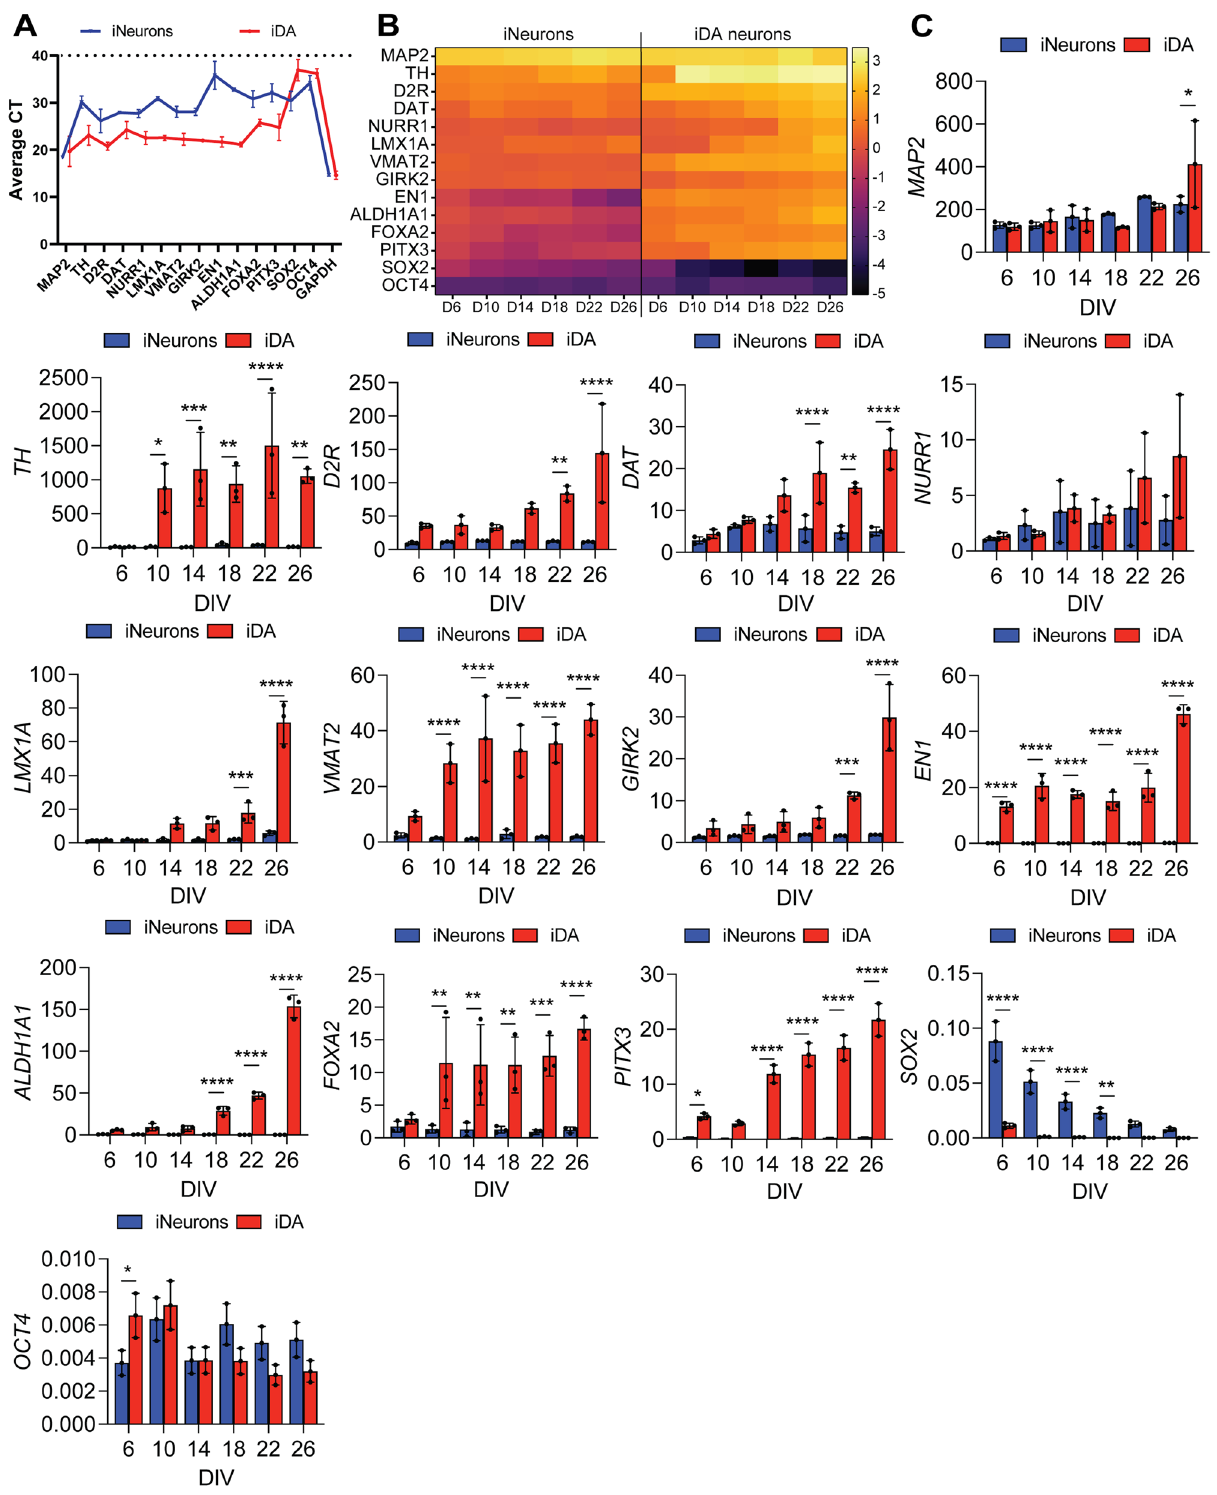
Figure 2. iDA neurons gene expression patterns mimic the gene expression signature of midbrain DA neurons. ( A ) Comparison of gene expression profiles in iNeurons and iDA neurons at DIV 26. The plot represents average CT values of the genes with a cut-off of 40 cycles (n = 3). ( B ) Whole sample quantitative qRT-PCR analysis of the expression levels of the key genes examined. Expression levels, expressed as log changes, are color coded following the color scale on the right. mRNA levels were quantified at each time point for iNeurons or iDA neurons (n = 3). ( C ) Comparison of gene expression profiles in iNeurons and iDA neurons as examined over time, differentiated from iNeurons at DIV 2. The graphs depict the fold-change expression of each gene normalized to the DIV 2 cells (n = 3). Statistical differences were assessed performing a 2-way ANOVA Šídák’s multiple comparisons test comparing iDA neurons to iNeurons at each time points. * p < 0.05; ** p < 0.01; *** p < 0.001; **** p <